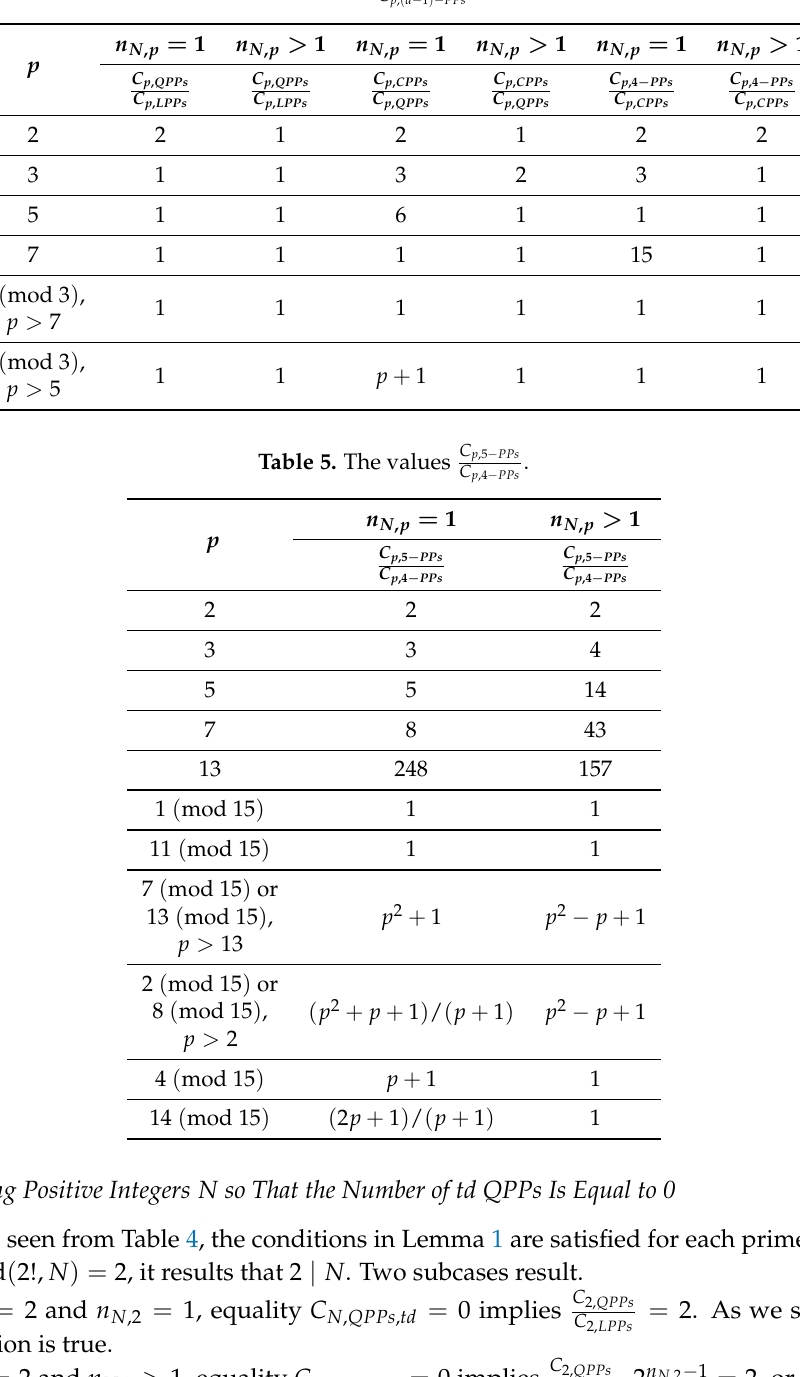
Table 4. The values C p , d − PPs